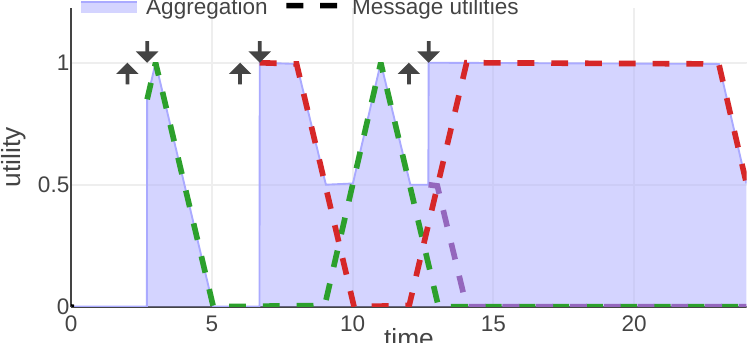
Figure 8. A loc and U loc functions plotted for a mission example. c (cid:13) 2019 IEEE. Reprinted, with permission, from